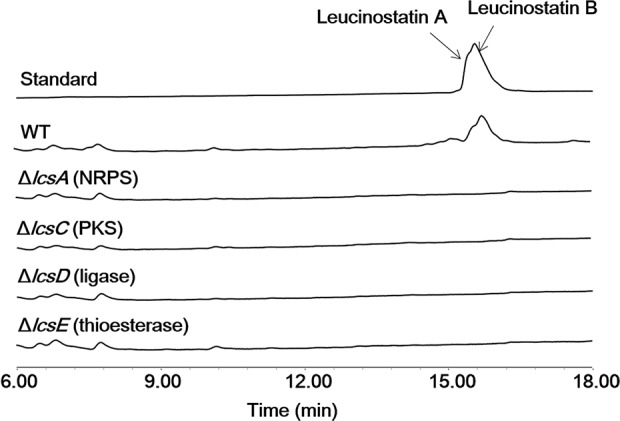
HPLC profiles (UV 210 nm) of culture extracts from the wild type P. lilacinum strain and mutants when grown in PDB medium.Leucinostatins A and B were detected in the wild type isolate, while they were abolished in ΔlcsA, ΔlcsC, ΔlcsD and ΔlcsE.